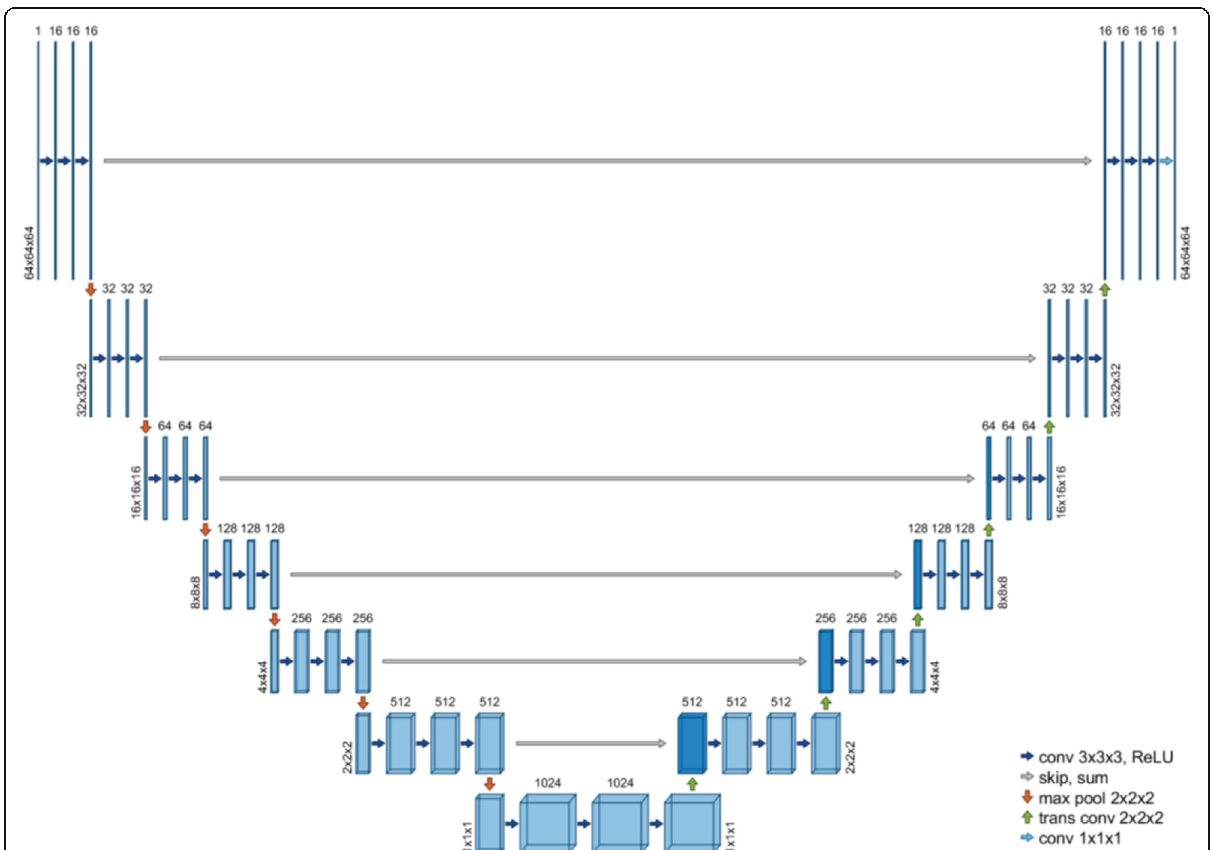
Fig. 1 The CNN used in this study followed a U-Net architecture with encoding and decoding paths, connected with direct skip-sum layers at each resolution